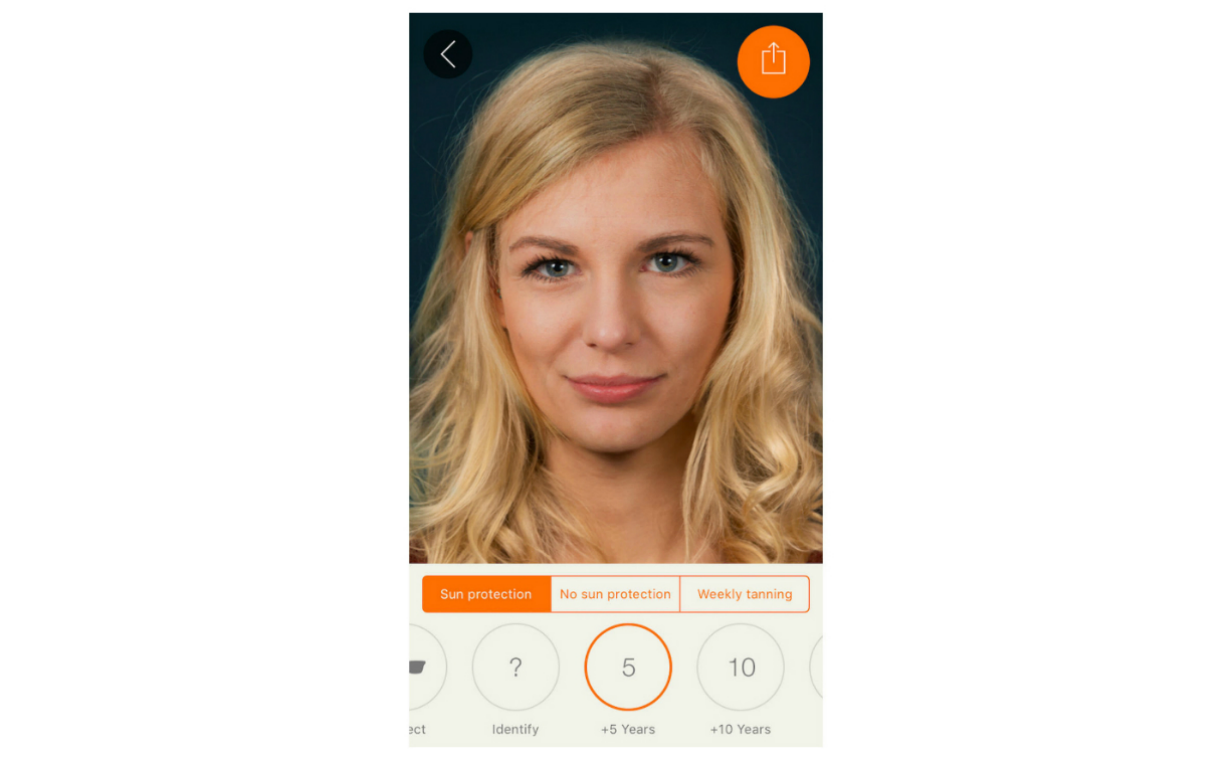
Figure 1. Effect view: 5 years of skin aging with sun protection.